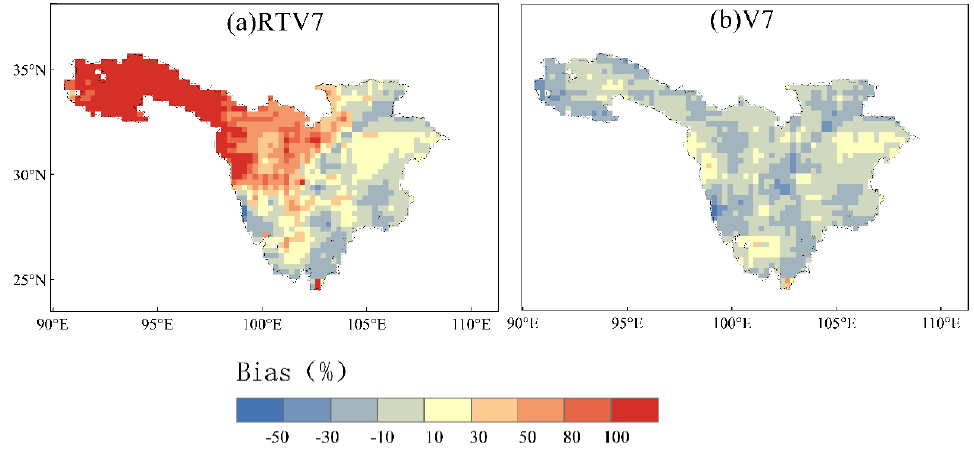
Figure 3. The spatial distributions of relative bias percentage (%) from the TMPA RTV7 / V7 precipitation against the gauged